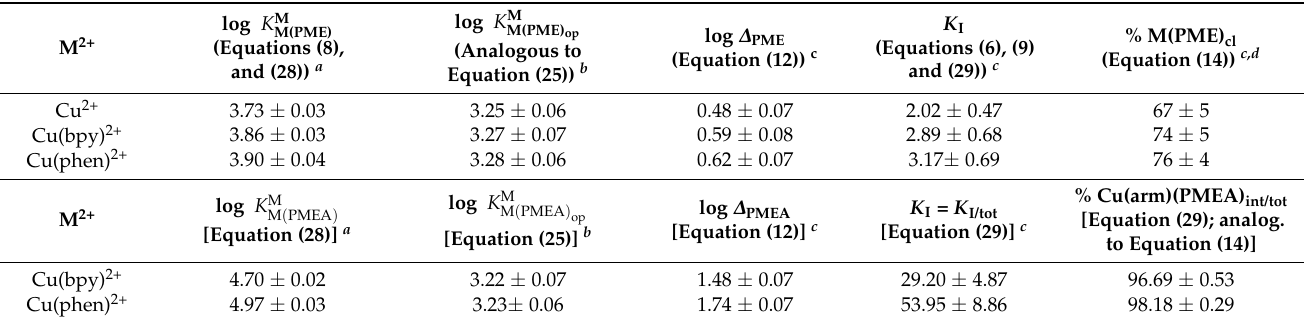
Table 7. Quantification of the stability increase via log ∆ (analogous to Equation (12)) for the Cu(arm)(PME) and Cu(arm)(PMEA) complexes and extent of the intramolecular chelate formation (Equation (14)) in the Cu(arm)(PME) complexes at 25 ◦ C and I = 0.1 M (NaNO 3 ); the results for the corresponding binary Cu(PME) complex are given for